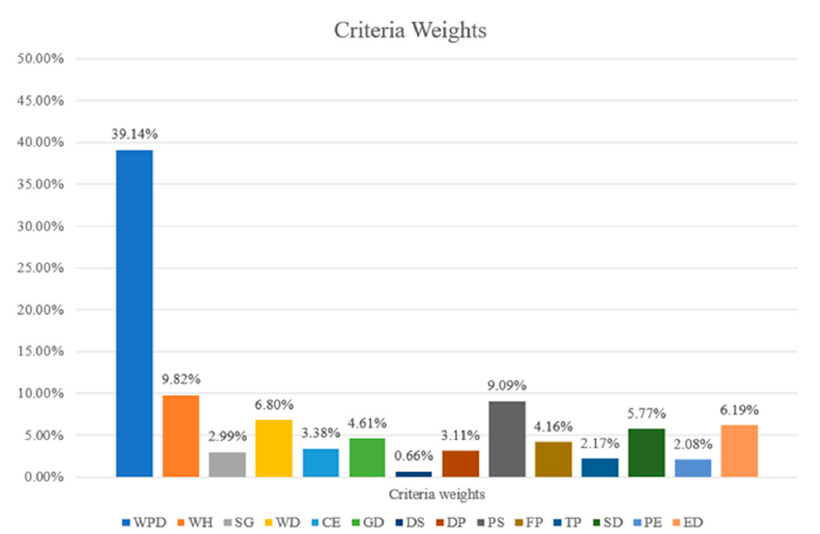
Figure 8. Criteria weights.